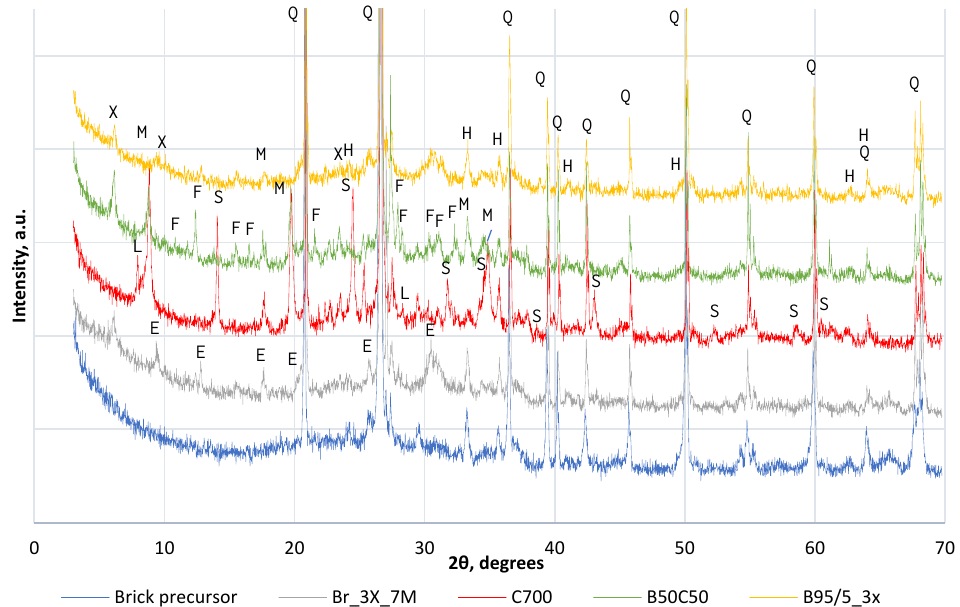
Figure 4. XRD results of AAM. X — faujasite (76-843), Q — quartz (79-1910), H — hematite, syn (13- 534), S — hydrosodalite (72-2329), L — montmorillonite (11-303), M — muscovite (7-25), F — philipsite